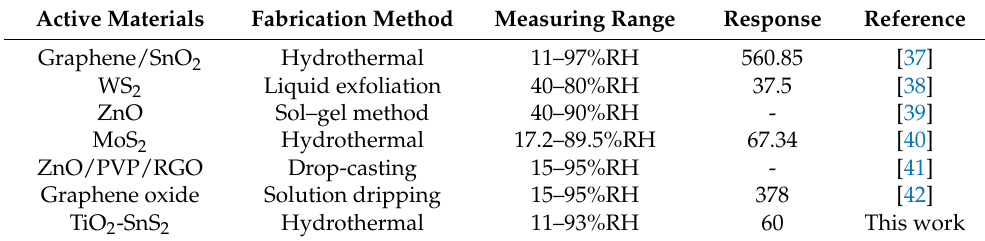
Table 1. Comparison of the main features of previously reported humidity